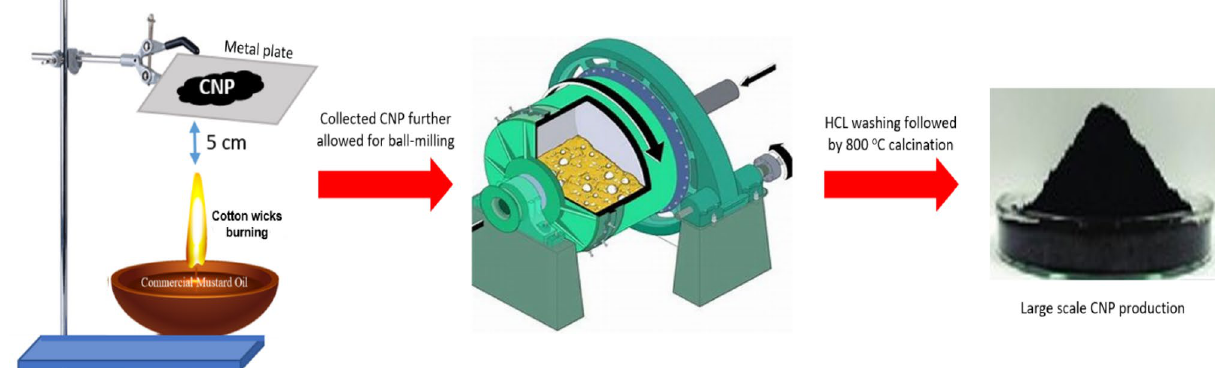
Figure 1. Schematic representation of carbon nanoparticles synthesis utilizing burnt cotton